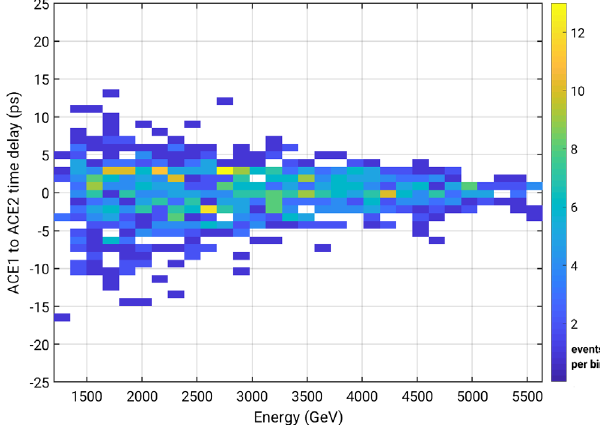
FIG. 15. Time delay resolution as a function of shower energy, for the two higher-SNR ACE channels, ACE1 and